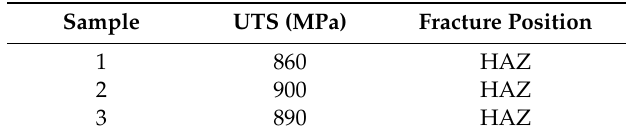
Table 4. Tensile testing results of the repaired sample.